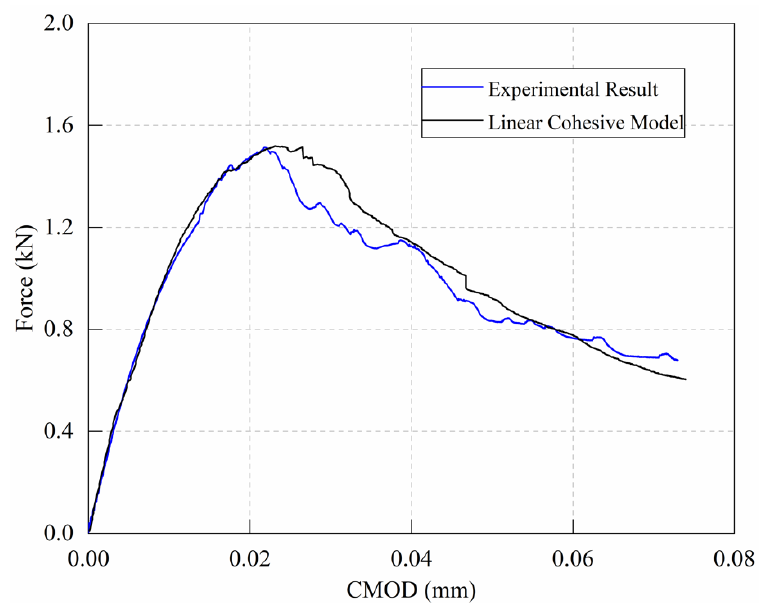
10 of 17 Figure 11. Specimen geometry and boundary condition for the notched mortar beam. The micro-parameter calibration process of the notched mortar beam was performed using the method proposed previously by the authors [26]. The obtained parameters are listed in Table 5, and the simulation results are shown in Figure 12. Table 5. Micro-parameters of the linear cohesive model obtained after calibration for small beam test.